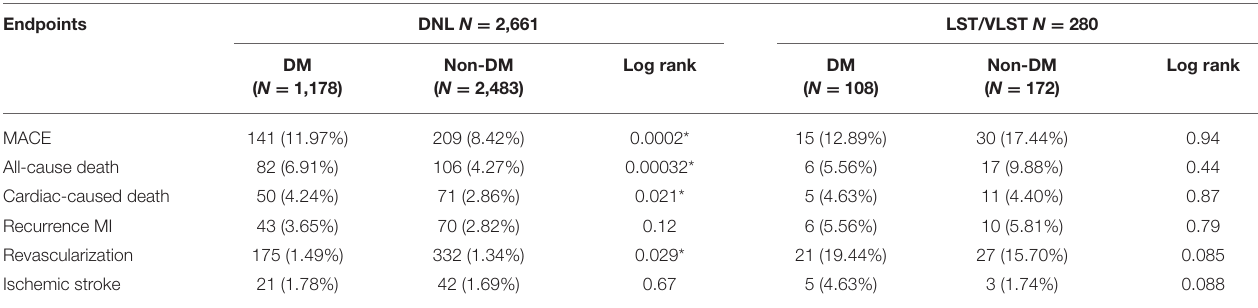
TABLE 4 | The cumulative incidence of clinical outcomes by Kaplan–Meier analysis at median 698 follow-up days among all enrolled patients.